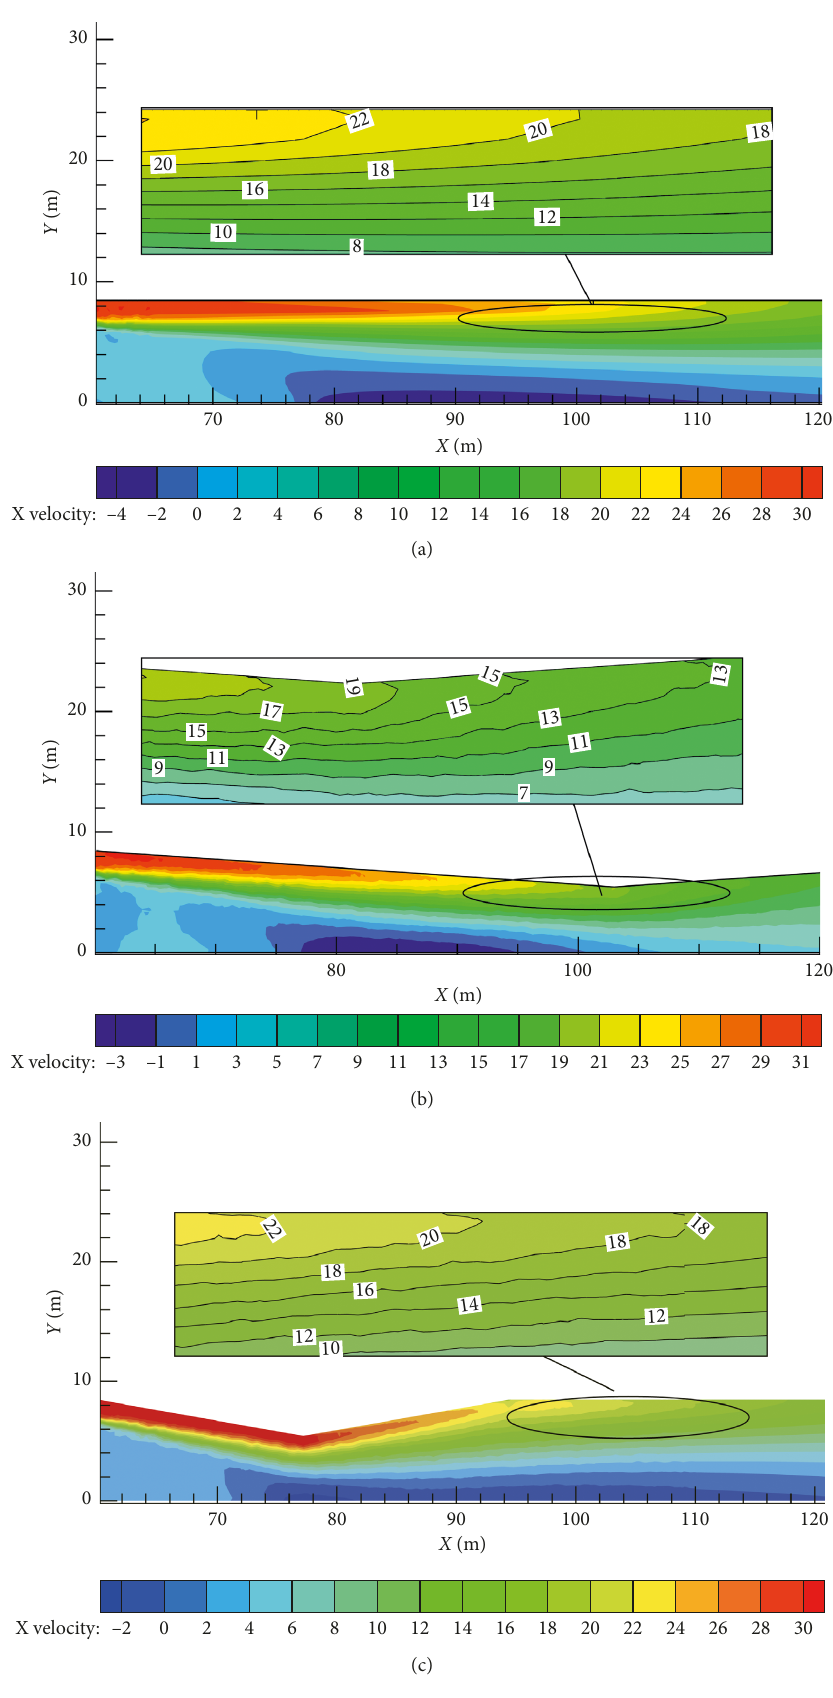
Figure 11: Local velocity distribution on X - Y plane for u